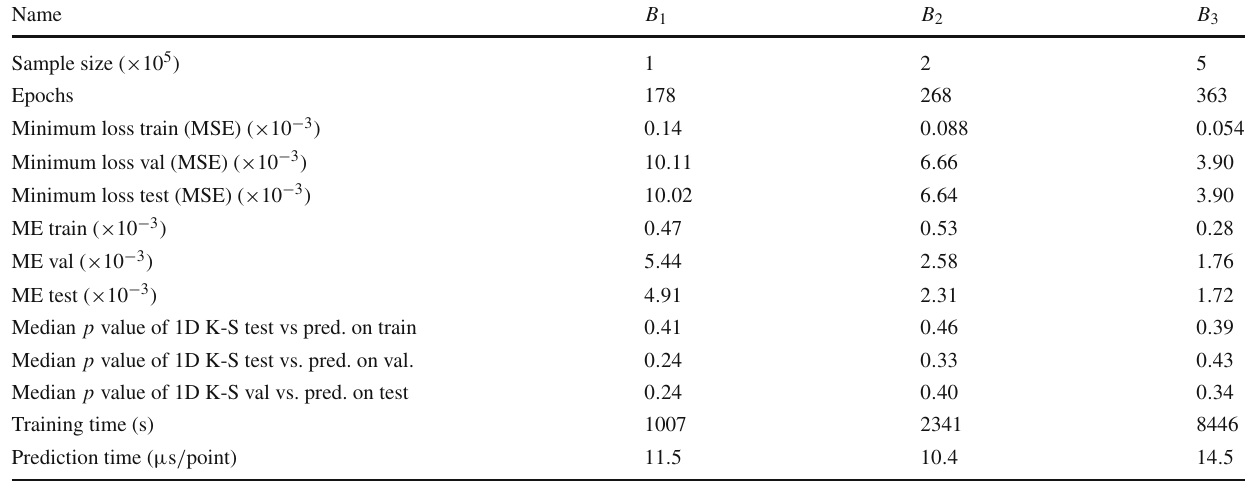
Table 2 Results for the best models (Bayesian DNNLikelihood) for different training sample size. All models have been trained for 5 times to check the stability of the result and the best performing one has been quoted. Prediction time is evaluated on a test set with half the size of the